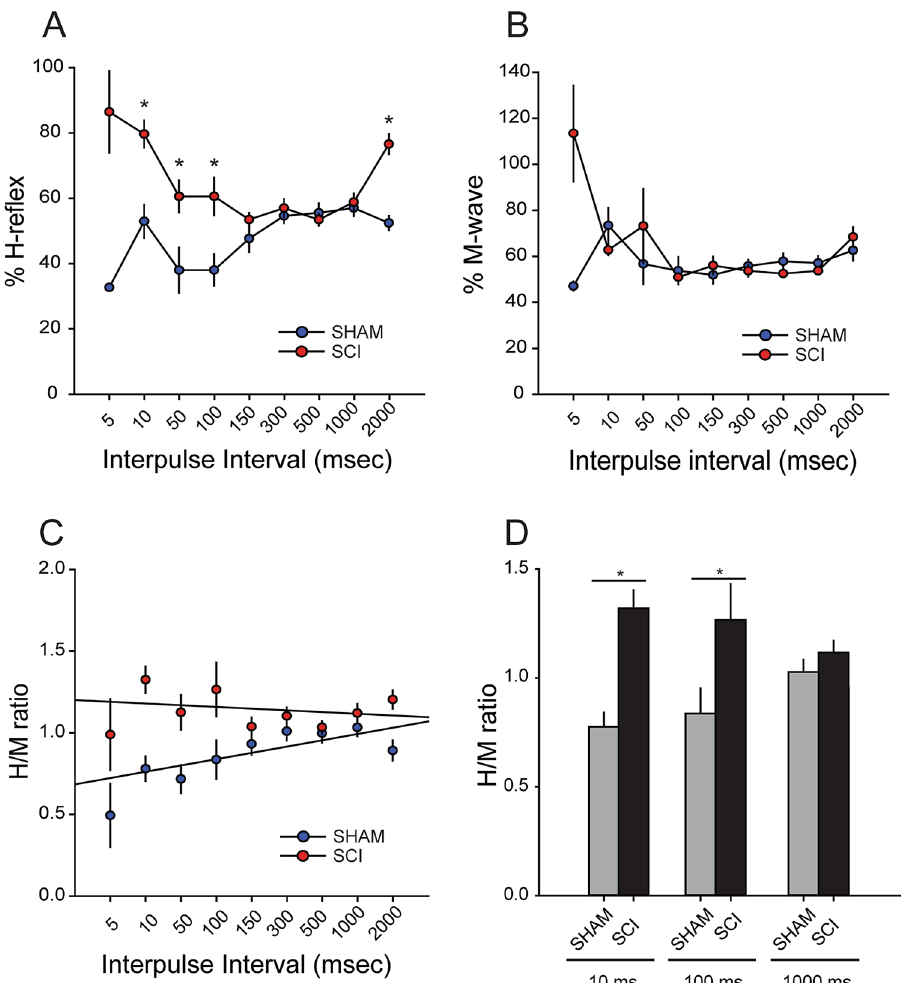
Figure 5. Enhanced H-reflex response 1-week after SCI. To confirm the development of hyperreflexia after SCI, we measured the H-reflex response using a paired-pulse paradigm (stimulating interpulse intervals 5–2000 ms). ( A , B ) % H-reflex and % M-wave are normalized values of the test pulse compared to the control pulse. ( A ) In Sham animals, shorter interpulse intervals are associated with less %H-reflex, demonstrating RDD. After SCI there was significant increase in the %H-reflex at 10, 50, 100 and 2000 ms interpulse intervals (* = p < 0.05). ( B ) There was no significant difference in %M-wave response between Sham and SCI. ( C ) H/M ratio was calculated by comparing peak amplitude of the test pulse evoked H- and M-wave response. H/M ratio in Sham produced a greater linear regression slope as compared to SCI, e.g., shallow slope. ( D ) SCI significantly increased the H/M ratio at 10 and 100 ms compared to Sham (* = p < 0.05). Graphs are mean ±